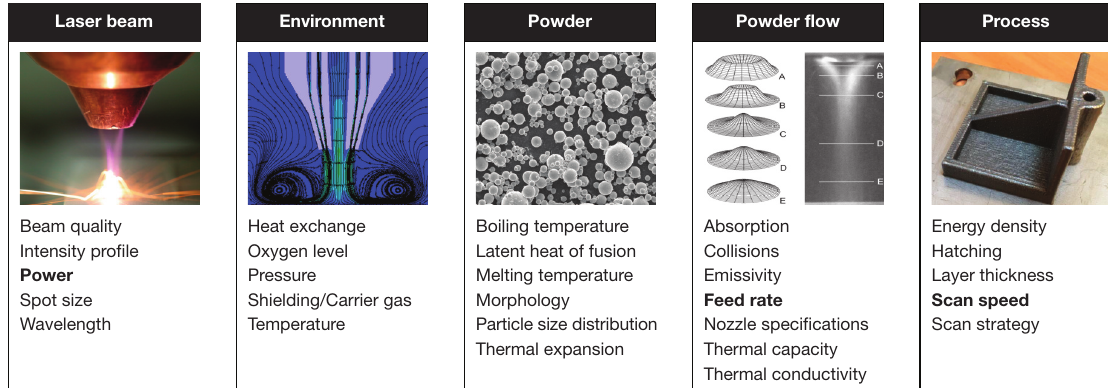
Figure 1. Main parameters that affect the Laser Powder Directed Energy Deposition (LP-DED)